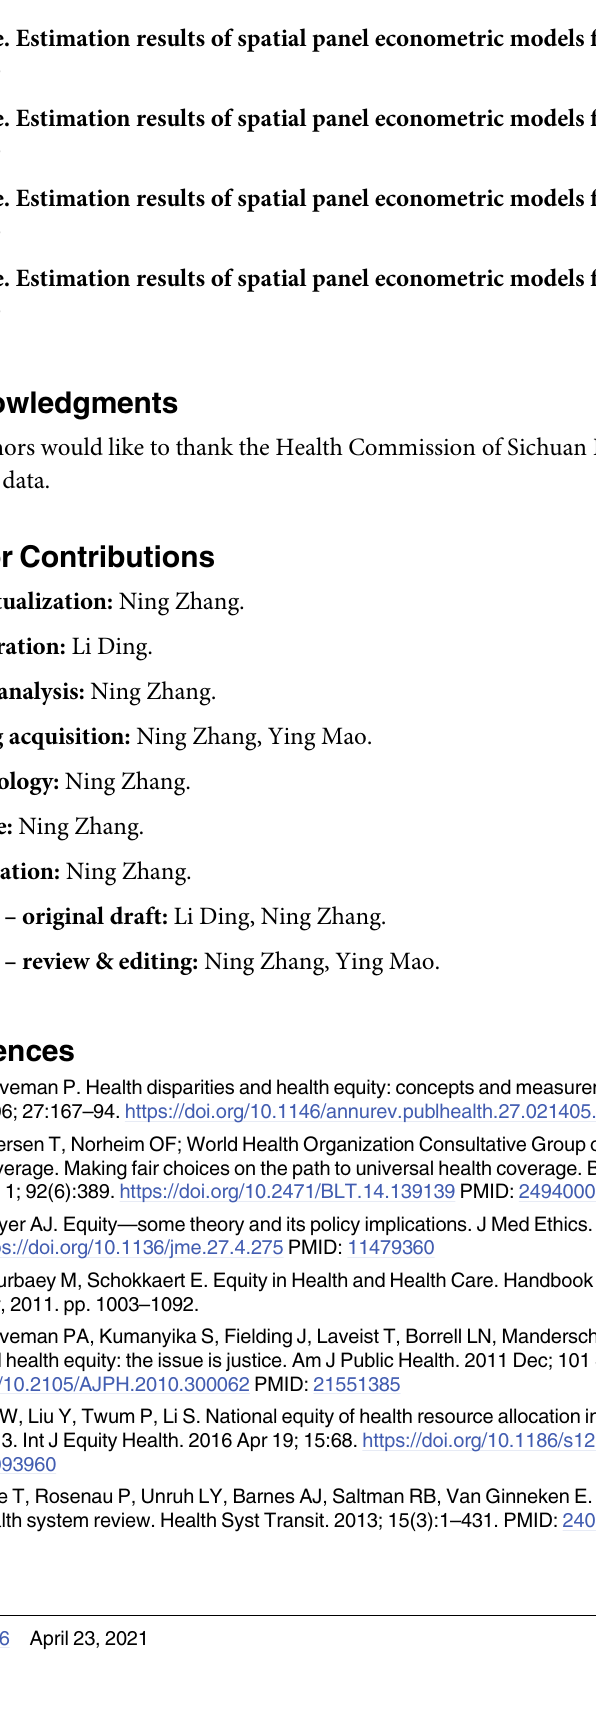
S3 Table. Estimation results of spatial panel econometric models for RND. S4 Table. Estimation results of spatial panel econometric models for BD. S5 Table. Estimation results of spatial panel econometric models for